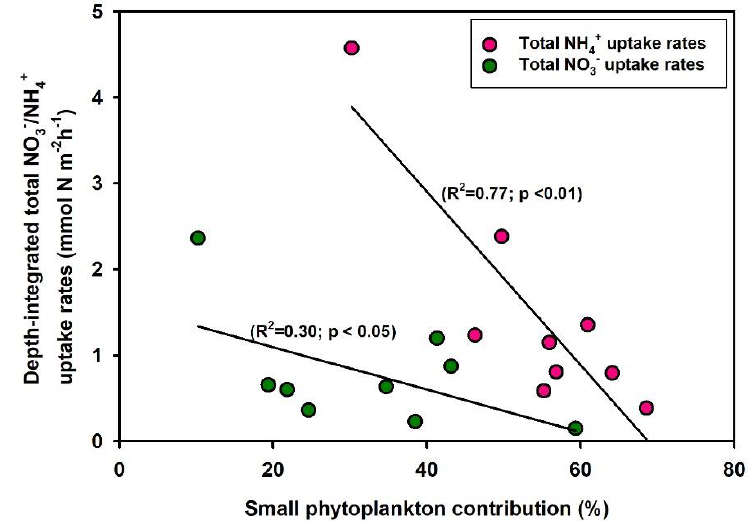
Figure 9. Relationships between small phytoplankton contributions to NO 3− /NH 4+ uptake rates and total NO 3− /NH 4+ uptake rates in the northeastern East/Japan Sea during 2015. The green and magenta dots indicate depth-integrated total NO 3− and NH 4+ uptake rates, respectively. The significance levels for the correlations are obtained from the t -test.